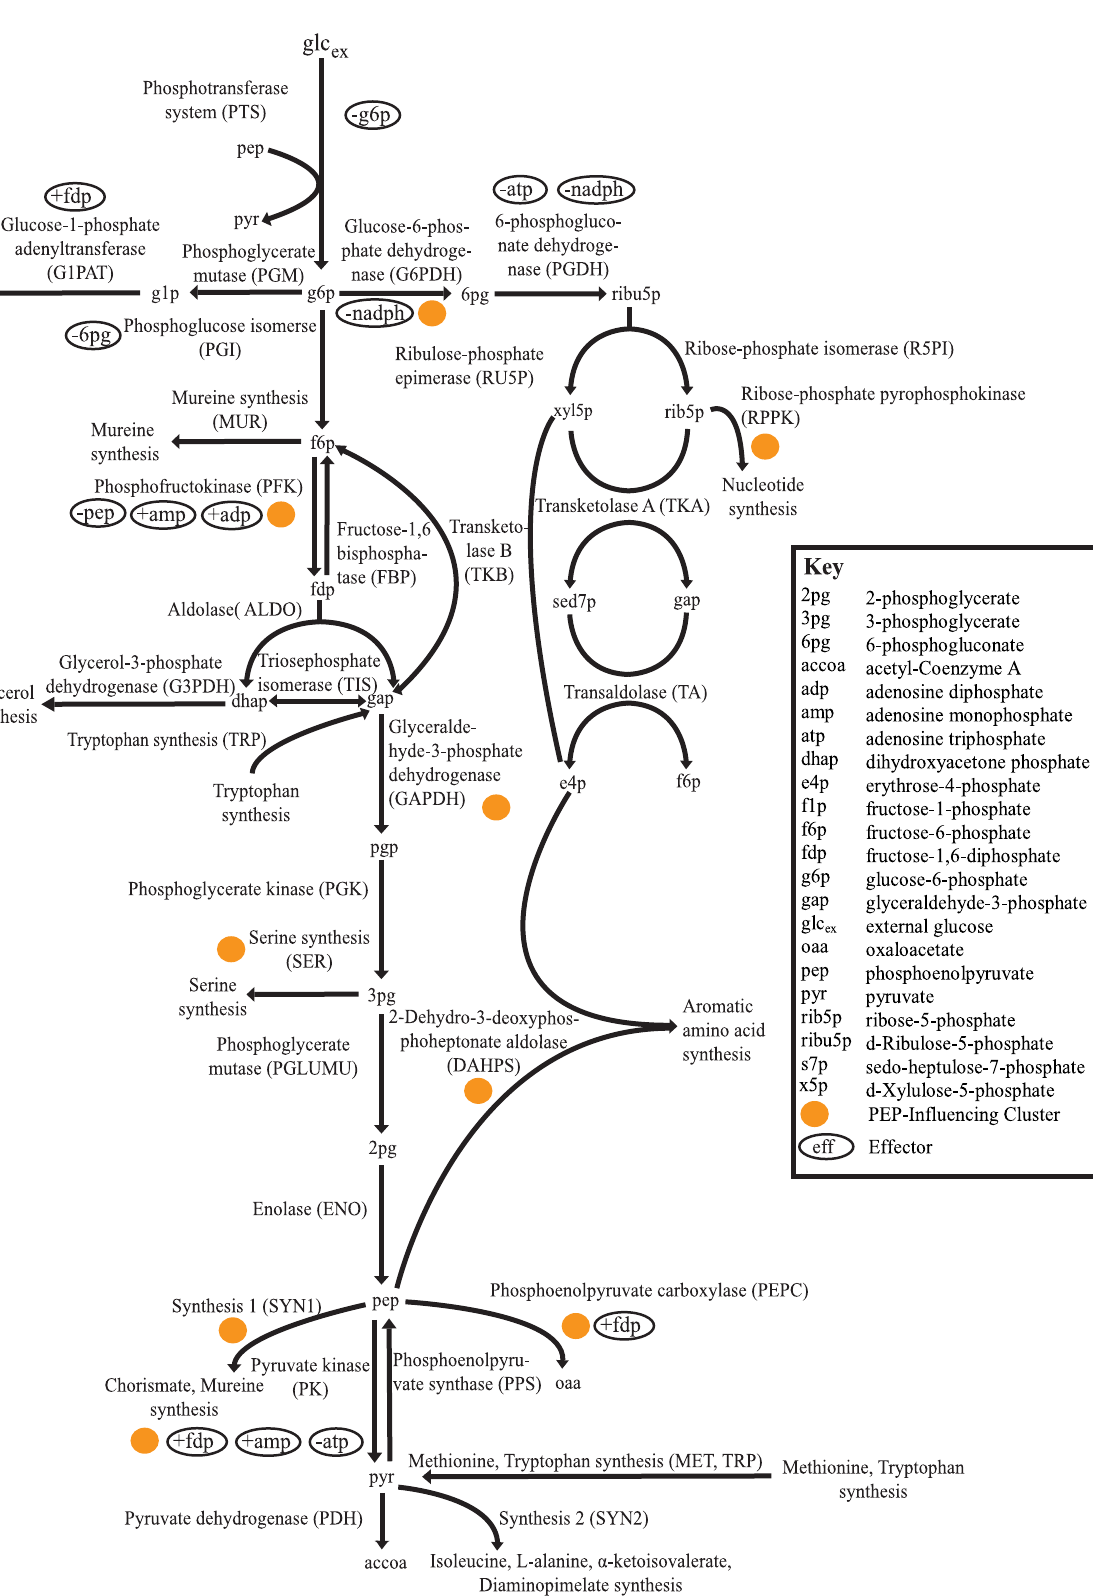
PLOS Computational Biology | www.ploscompbiol.org 3 June 2014 | Volume 10 | Issue 6 |